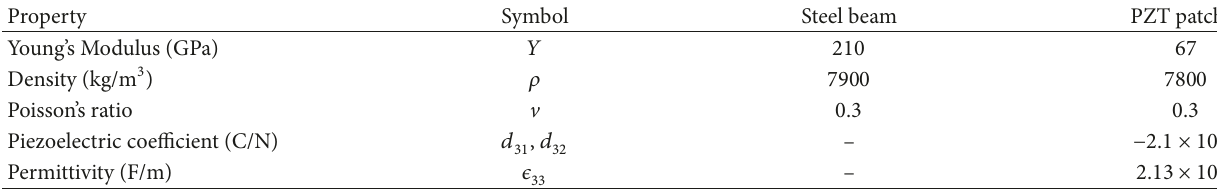
Table 2: Material properties of the steel beam and PZT patches.